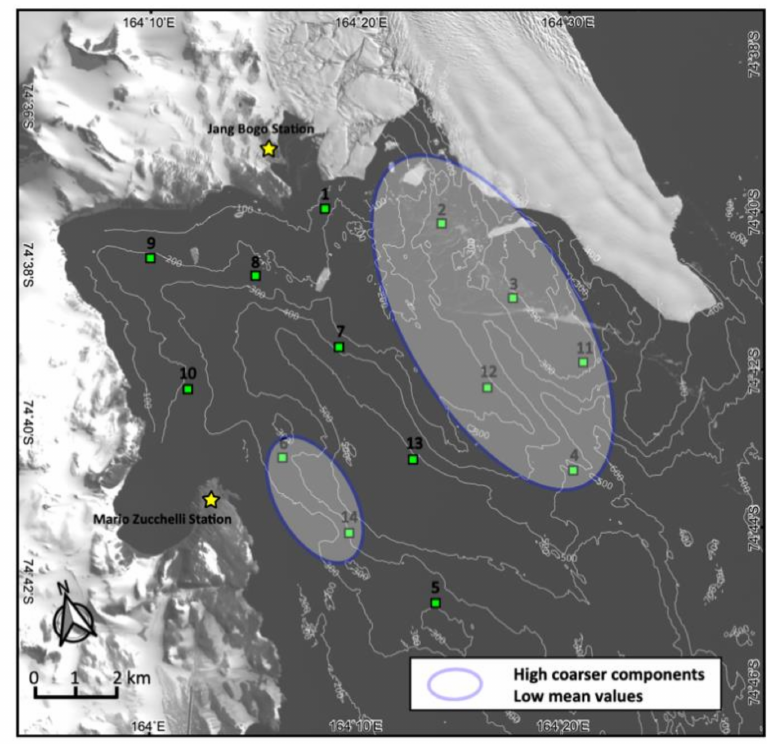
Figure 5. The relative mean size and coarse-sized component of surface